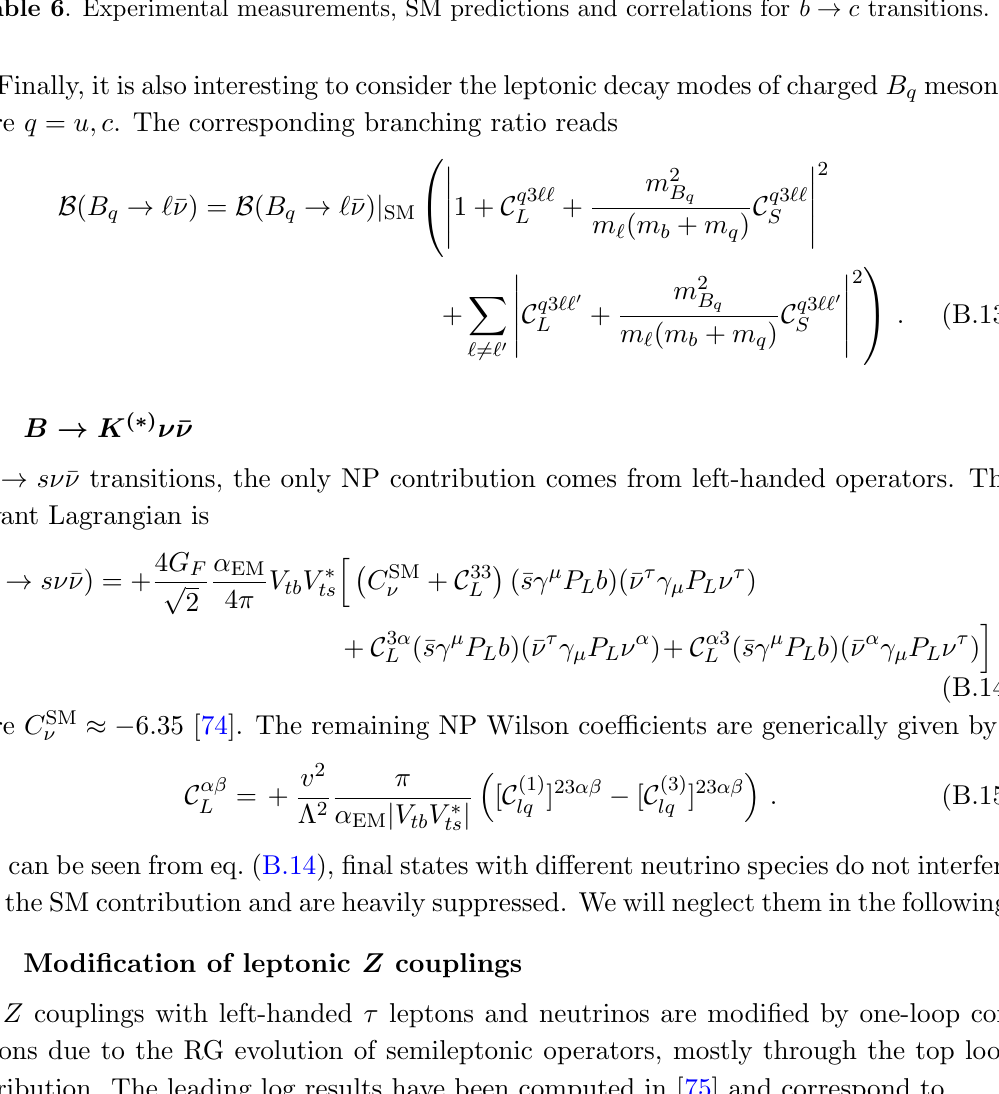
Table 6 . Experimental measurements, SM predictions and correlations for b ! c